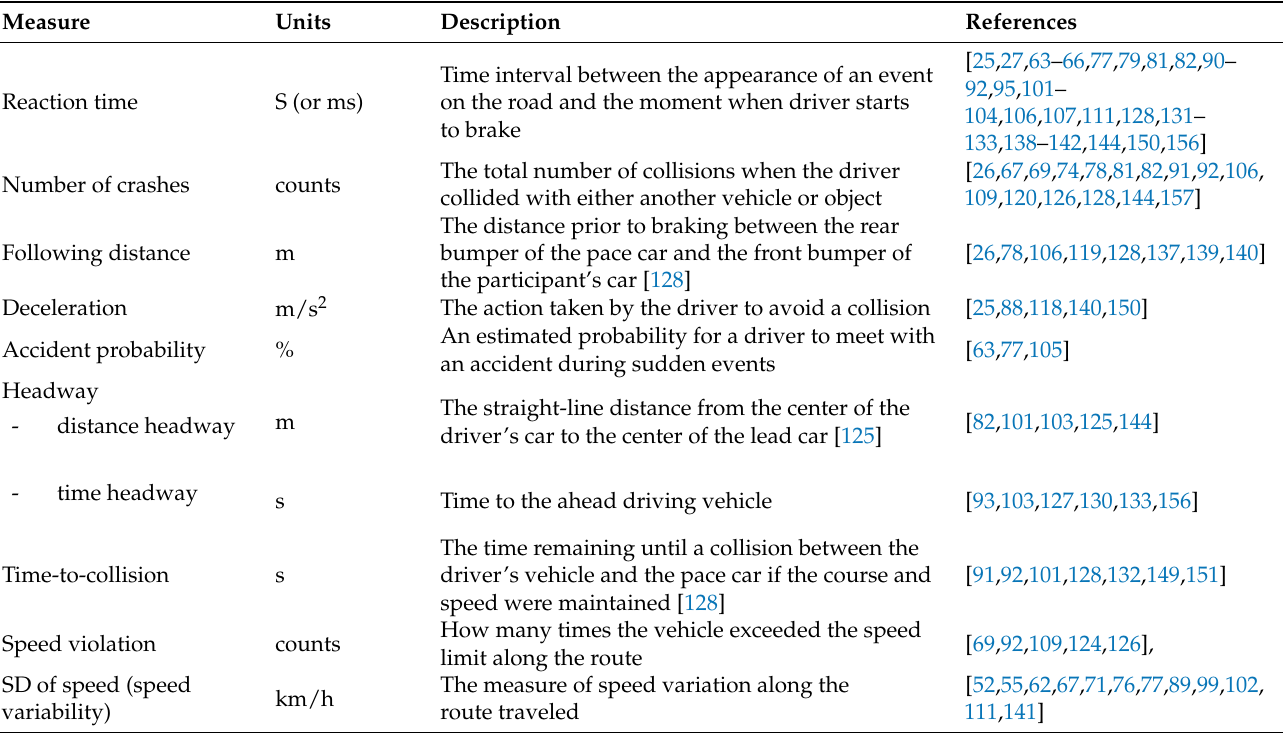
Figure 7. Distribution of papers according to the categories of driving performance measures. Table 4. Main measures used in the experiments of the analyzed